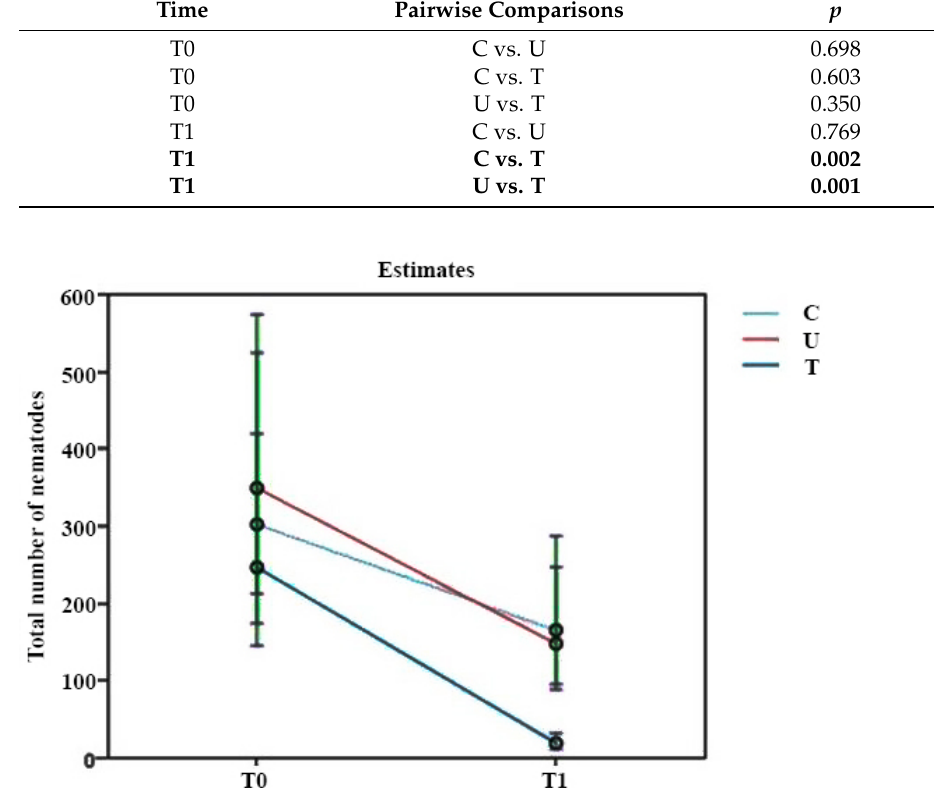
Figure 2. Interactive effect of time (before = T0 and after = T1 the three-trap crop cycles) and managements (Control: C, Uncultivated: U, and Treated: T) on the total number of Meloidogyne graminicola (eggs and juveniles) (average and 95% confidence interval are shown).